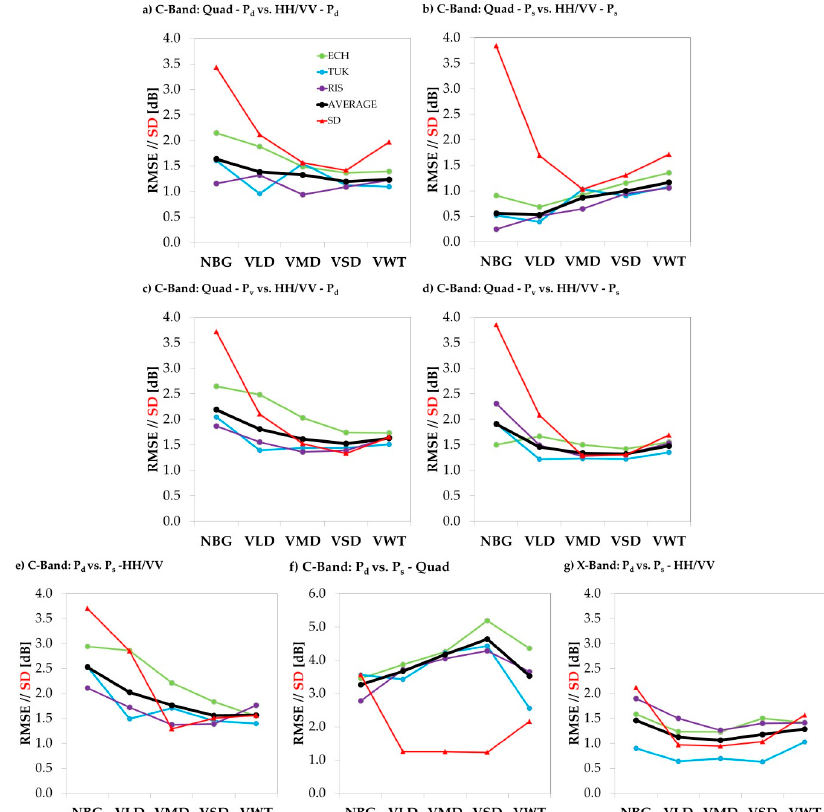
Figure 4. Root Mean Square Error (RMSE) of the linear models and the product of standard deviations of the two variables (SD) for none-water land cover classes (NBG, VLD, VMD, VSD, VWT) for: ( a ) double bounce (P d ) of the two and three component decomposition; ( b ) surface scattering (P s ) of the two and three component decomposition; ( c ) volume scattering (P v ) of three and P d of the two component decomposition (C-Band); ( d ) P v of three and P s of the two component decomposition (C-Band); ( e ) P d and P s of the two component decomposition (C-Band); ( f ) P d and P s of the three component decomposition (C-Band) and ( g ) P d and P s of the two component decomposition (X-Band). Note the different value range of the ordinate in sub-figure ( f ). Abbreviations of the test sites: TUK: Tuktoyaktuk, RIS: Richards Island, ECH: East Channel of the Mackenzie River.